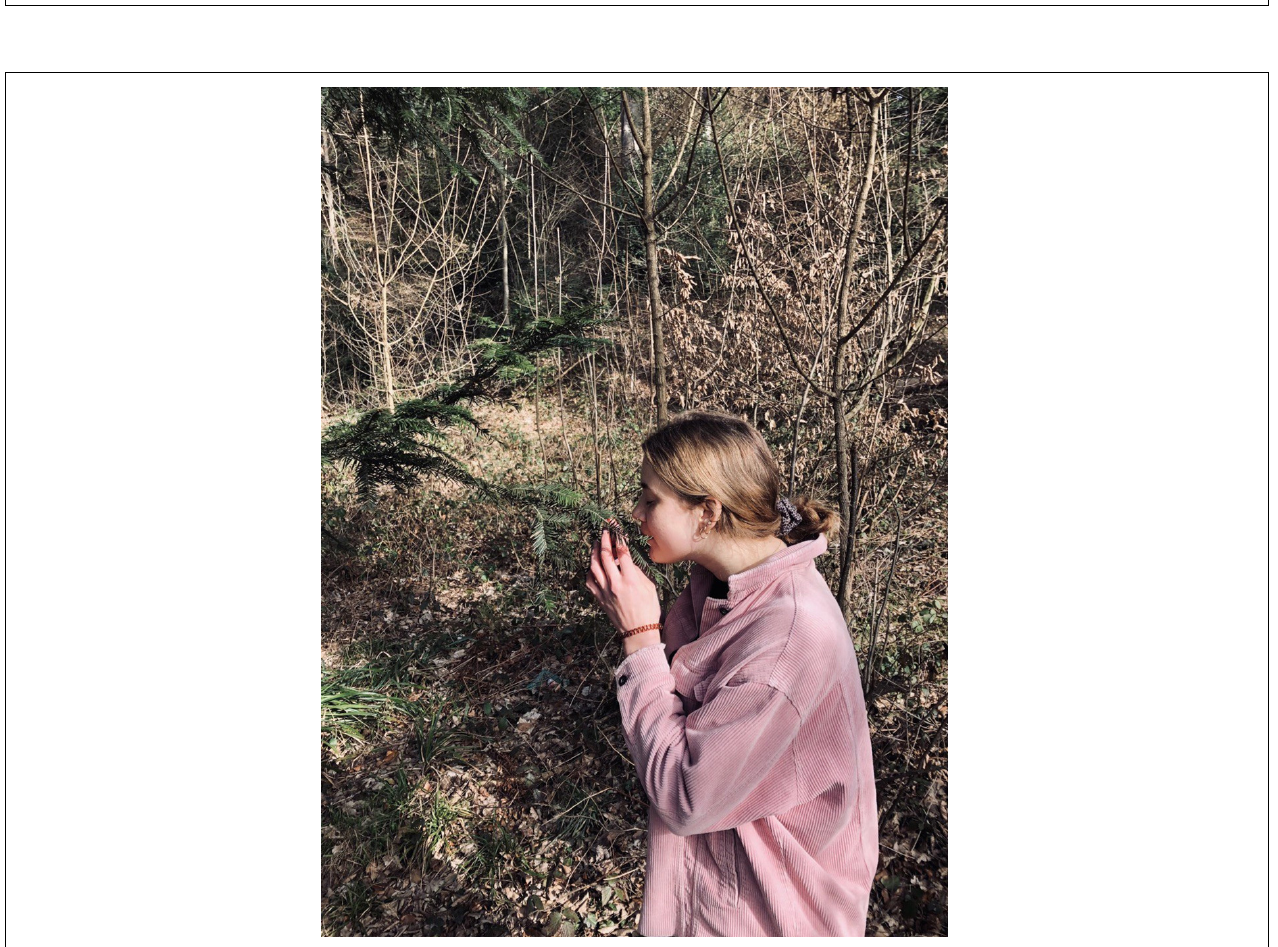
FIGURE 9 | Connecting to the forest with the help of the senses (source: Tabea Klinger).